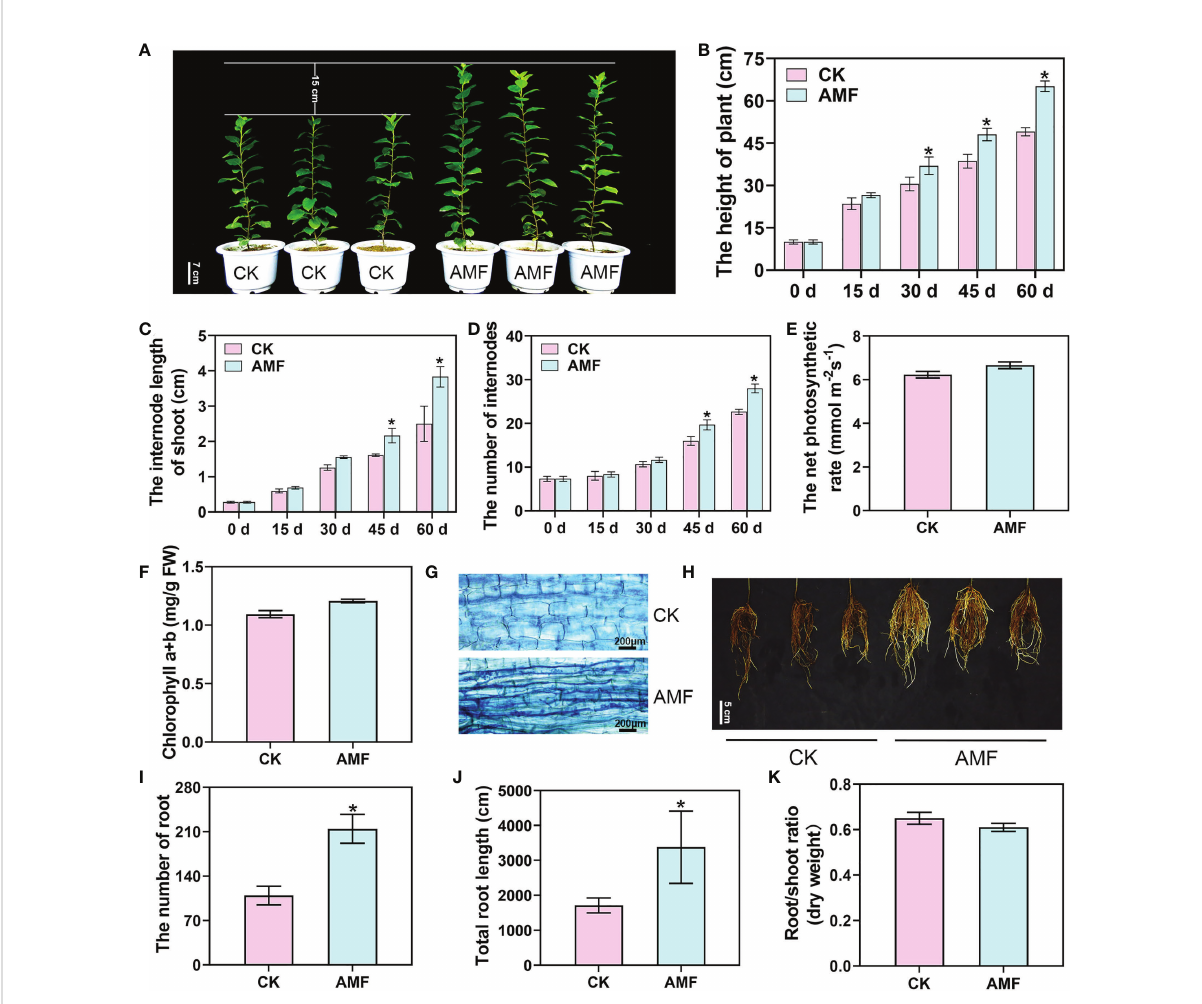
FIGURE 1 Apple plant growth and physiological responses to AM symbiosis. (A) The phenotype of mycorrhizal and non-mycorrhizal apple plants inoculated with Rhizophagus irregularis for 60 days. Scale bar = 7 cm. CK, non-mycorrhizal inoculated plants. AMF, mycorrhizal-inoculated plants. (B – D) The plant height, internode length, and internode number of apple plants uninoculated or inoculated with R . irregularis after 15, 30, 45 and 60 days, respectively. (E, F) The net photosynthetic rate and chlorophyll content of R . irregularis mycorrhizae uninoculated or inoculated apple plants after 60 days. (G) Staining of mycorrhizae in apple plants uninoculated or inoculated with R . irregularis after 60 days. (H) The root phenotype of uninoculated or inoculated apple plants after 60 days. Scale bar = 5 cm. (I-K) The number of roots, total root length, and root/shoot ratio of apple plants uninoculated or inoculated with R . irregularis after 60 days. Values are the means ± SD of three biological replicates. * Indicates a signi fi cant difference at P < 0.05